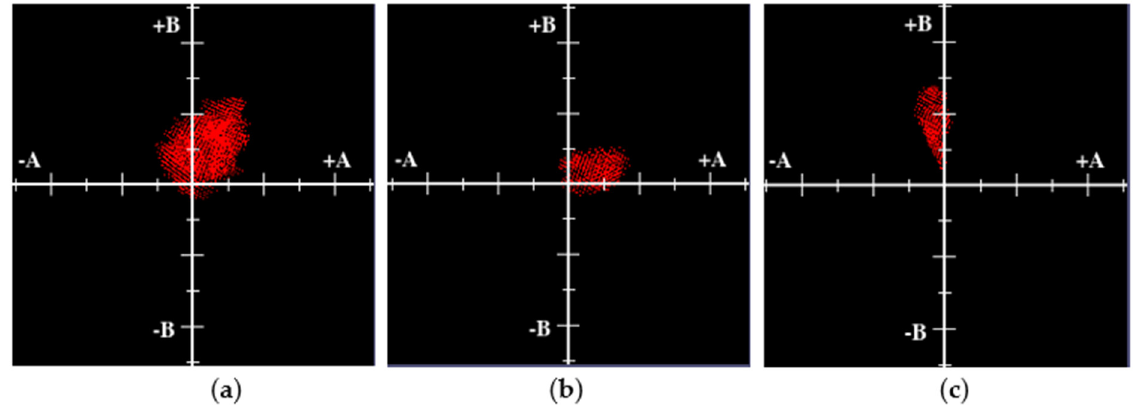
Figure 16. Two-dimensional color space, utilized in the software’s “negative-classifier”, showing location of common cotton colors ( a ), pink module wrap contaminant ( b ), and yellow module wrap contaminant ( c ).